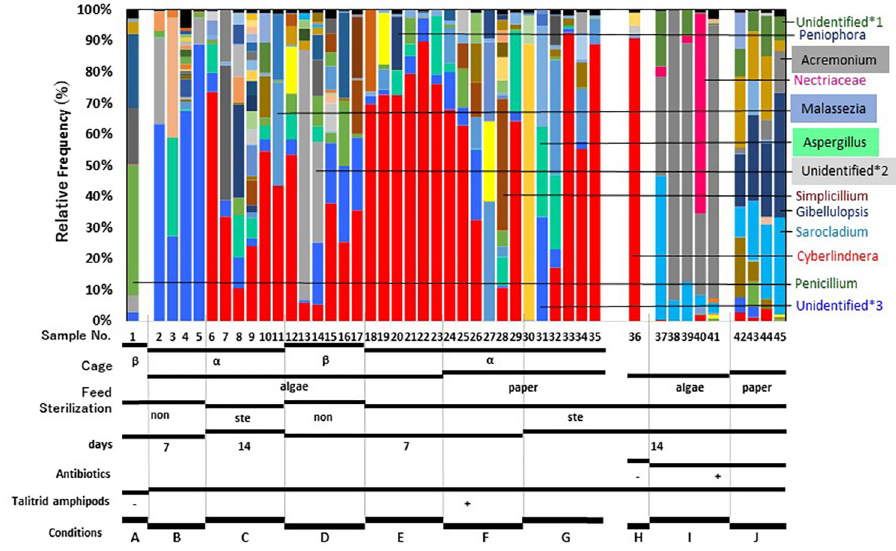
Fig 4. Bar plot of the relative frequency of ITS2 fungal data at the genus level. The frequencies of some genera are shown in S2